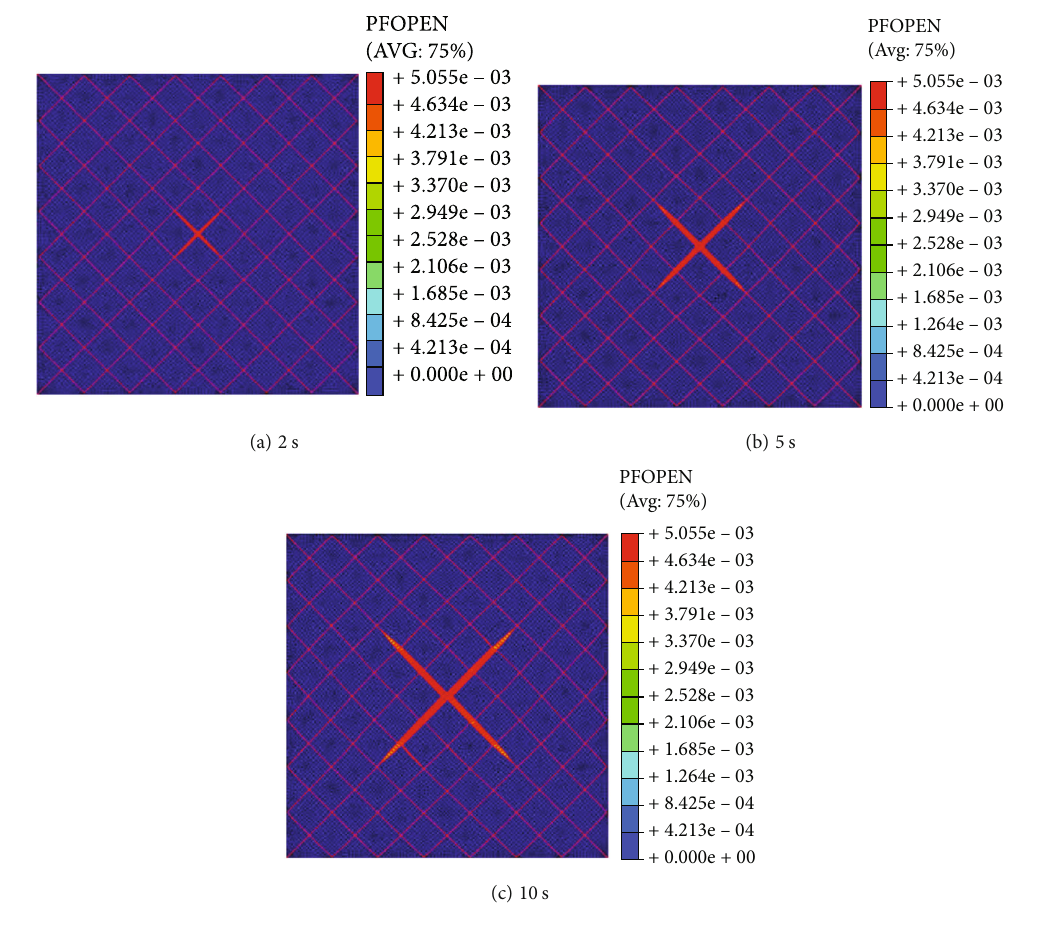
Figure 6: Main fracture opening distribution based on model I simulation. Table 2: Main parameters of material cohesive element in model